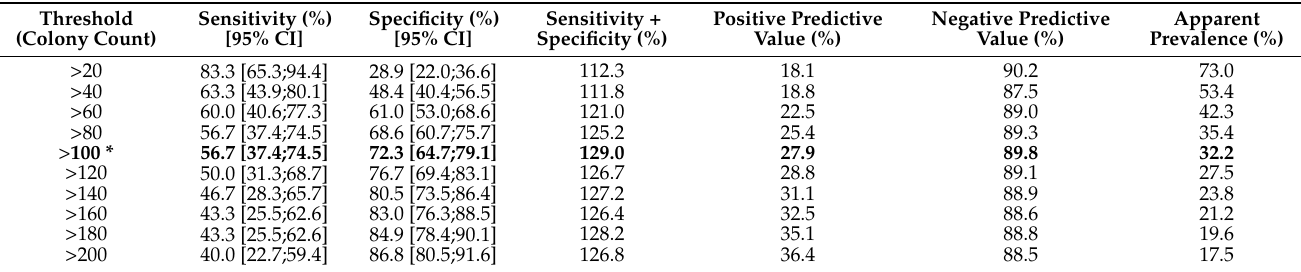
Table 1. Diagnostic performance of the Petrifilm on-farm culture system based on colony count thresholds in comparison with the reference test (VBLAB; n =